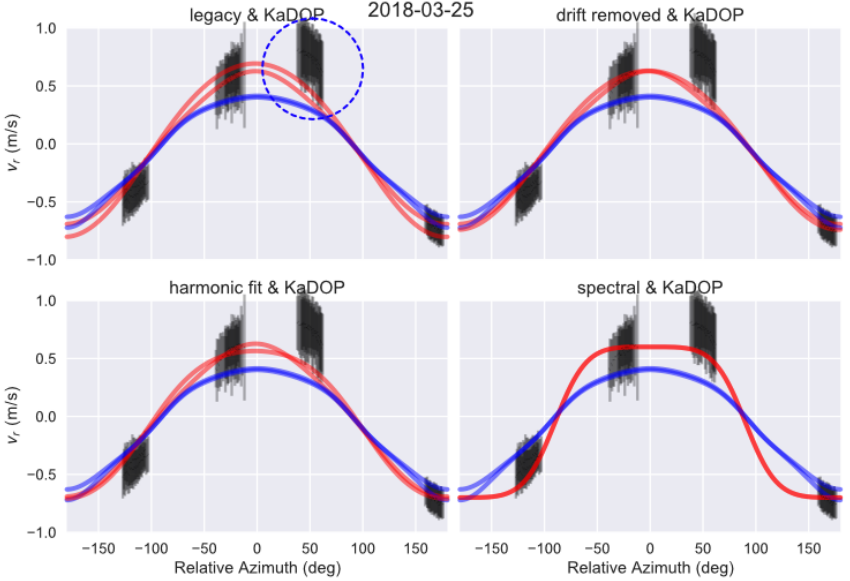
Figure 17. Same as Figure16, but for 3 m/s and 4 m/s bins collected on 2018-03-25. The anomalous values are highlighted by a dashed blue